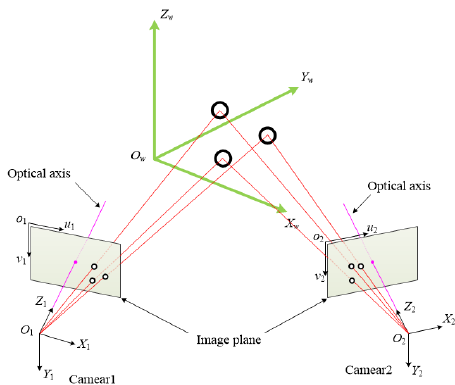
Figure 6. The photogrammetry principle.